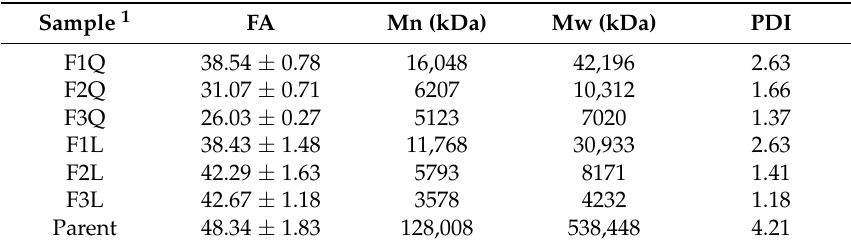
Table 2. Physico-chemical characterization of polymer samples.